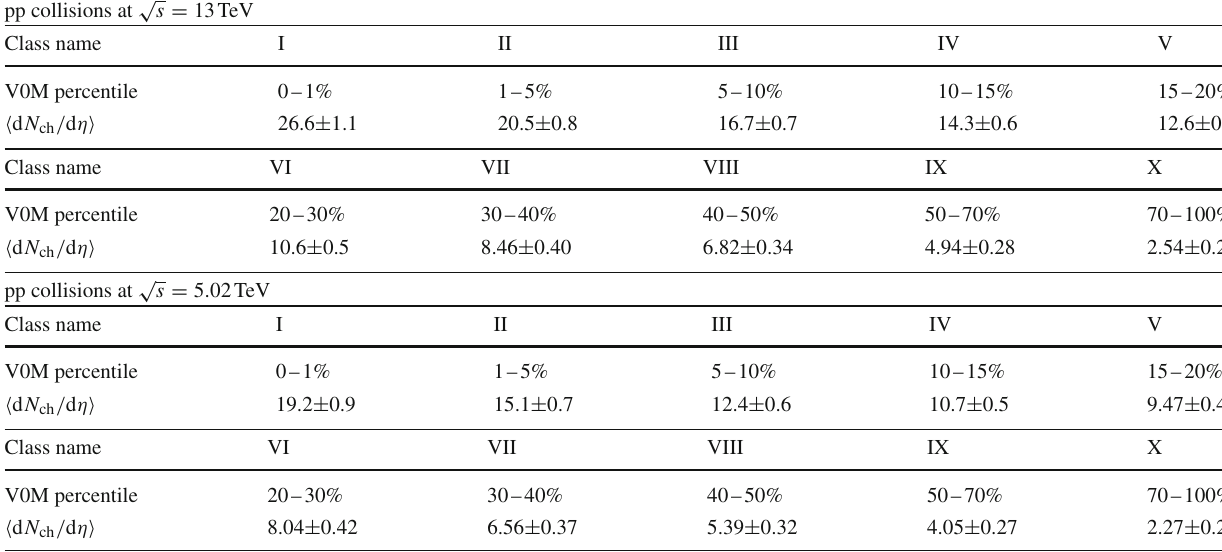
Table 1 V0M event multiplicity classes, their corresponding experimental definition and their corresponding (cid:3) d N ch / d η (cid:4) in | η | < 0 . 8. The uncertainties are the quadratic sum of statistical and systematic contributions. Statistical uncertainties are negligible compared to the systematic ones √ s = 13TeV pp collisions at